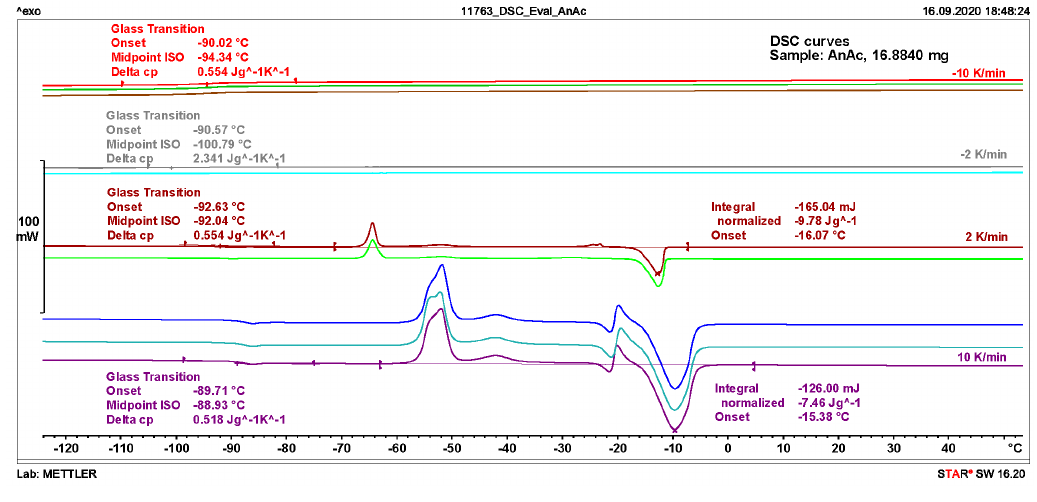
Figure A1. DSC data of AnAc.